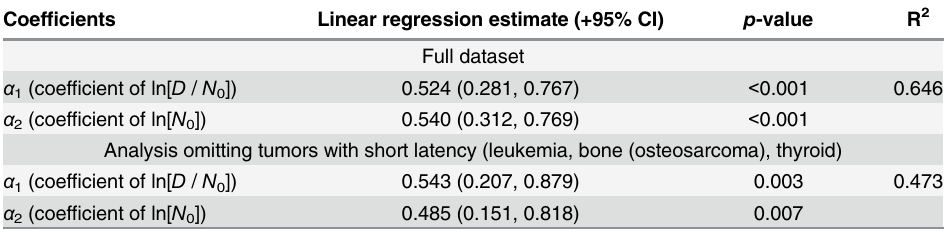
Table 3. Linear regression fits of model (9) to data of Tomasetti and Vogelstein [2] a , and in some cases omitting tumors with short latency (leukemia, bone,